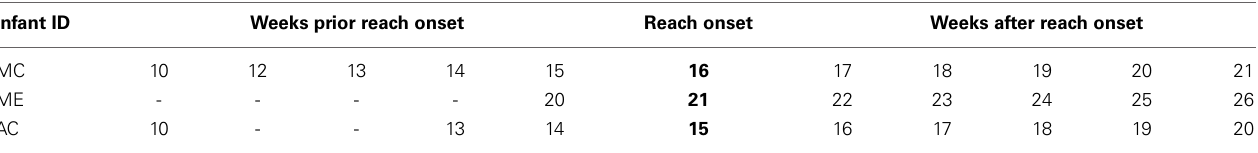
Table 1 | Ages (in weeks) for the three longitudinal infants when tested over the 11-week period. Infant